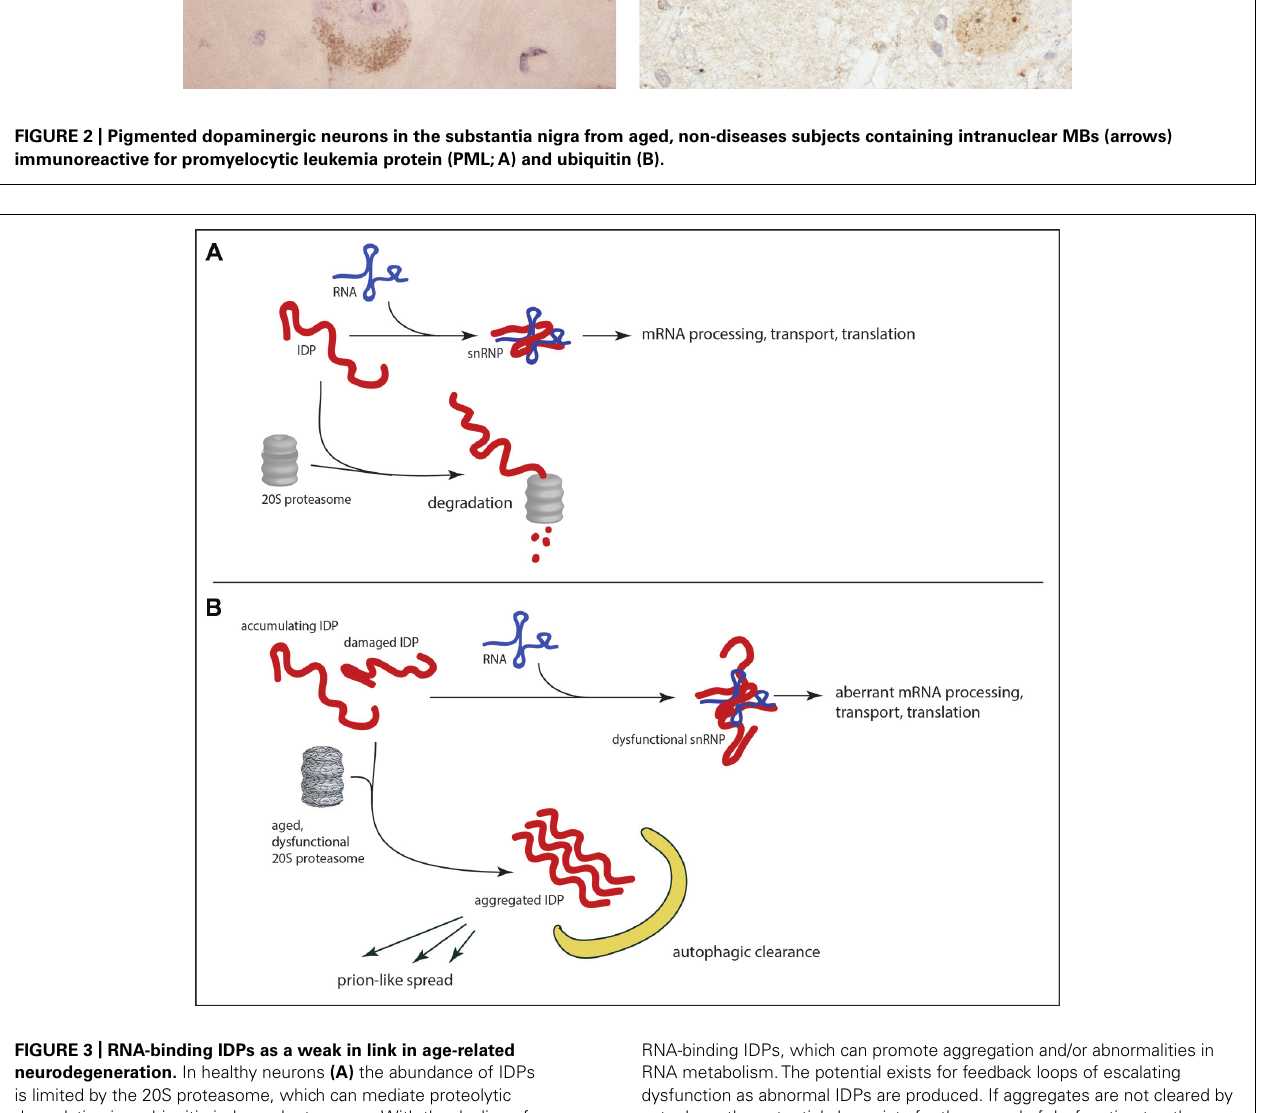
FIGURE 3 | RNA-binding IDPs as a weak in link in age-related neurodegeneration. In healthy neurons (A) the abundance of IDPs is limited by the 20S proteasome, which can mediate proteolytic degradation in a ubiquitin-independent manner.With the decline of proteolytic efficiency in the aged brain (B) there is accumulation of